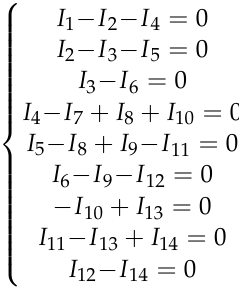
Figure 3. Application of KCL and KVL to the bilayer beam solar sail for current division. The red arrows represent the direction of currents across corresponding beams. The equivalent resistance of each bilayer grid beam was assumed to be 𝑅 , while that of each bilayer supporting beam was 2𝑅 .